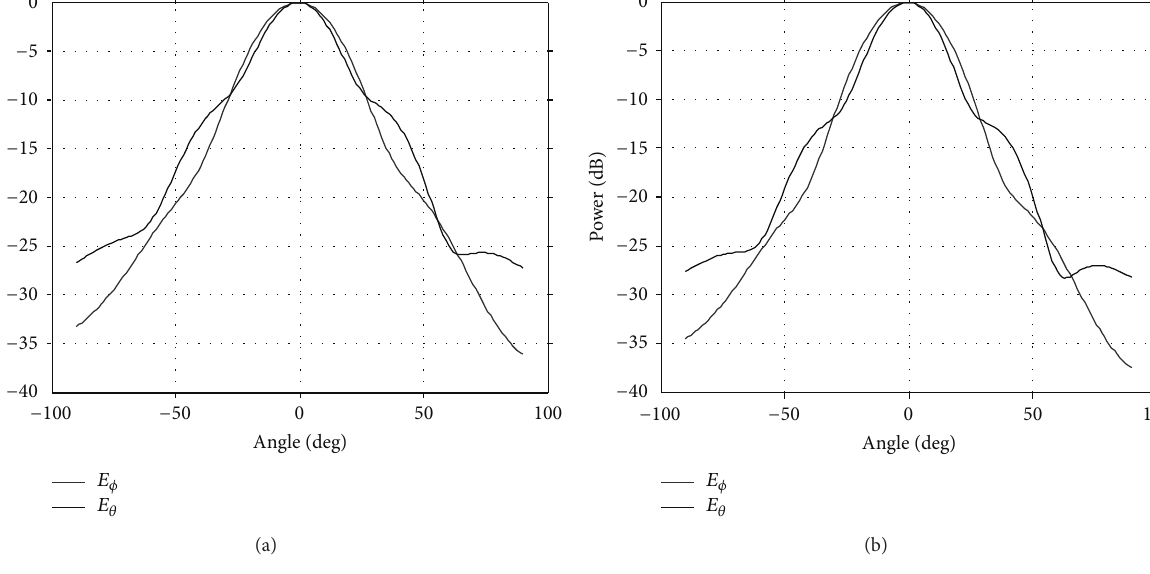
The simulation results of the near field amplitude and phase radiation patterns of the conical horn with semiflare angle